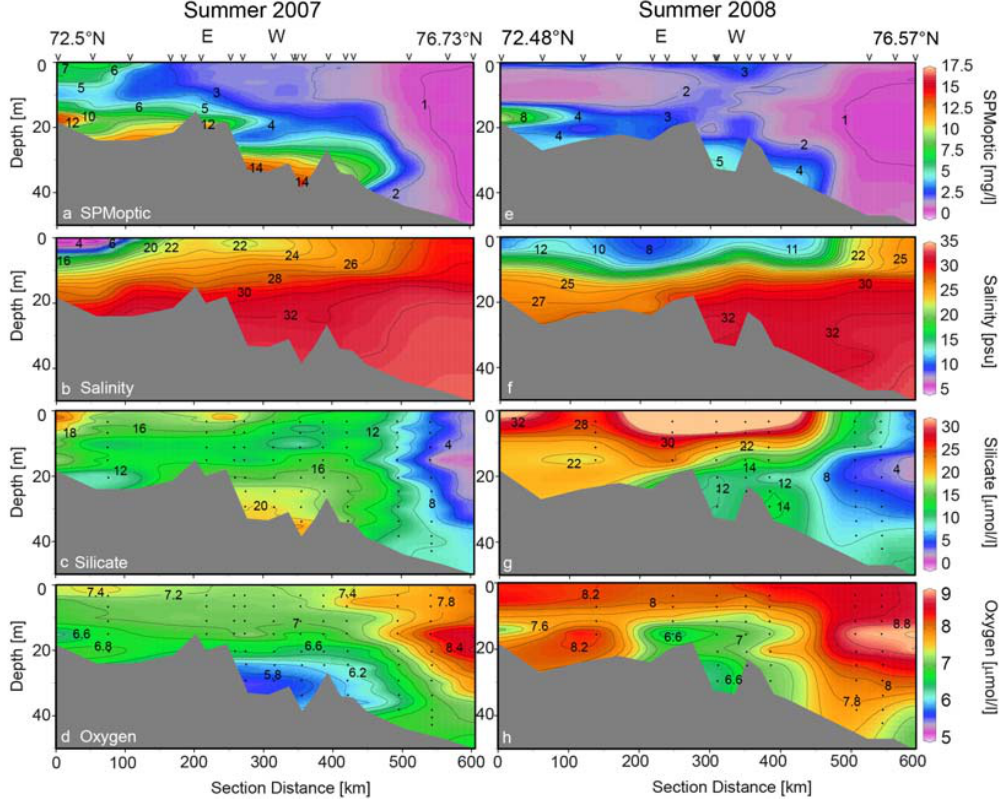
Fig. 4. A south–north section across the eastern Laptev Sea shelf during TD XII (summer 2007; sampling period in Julian days: 241–255) and TD XIV (summer 2008; sampling period in Julian days: 249–258) showing the distribution of SPM optic concentration ( a , e ; [mgL − 1 ]), salinity ( b , f ; [psu]), silicate concentration ( c , g ; [µmolL − 1 ]), and dissolved oxygen ( d , h ; [µmolL − 1 ]). As density on Arctic shelf seas is mainly determined by salinity, salinity instead of density is shown